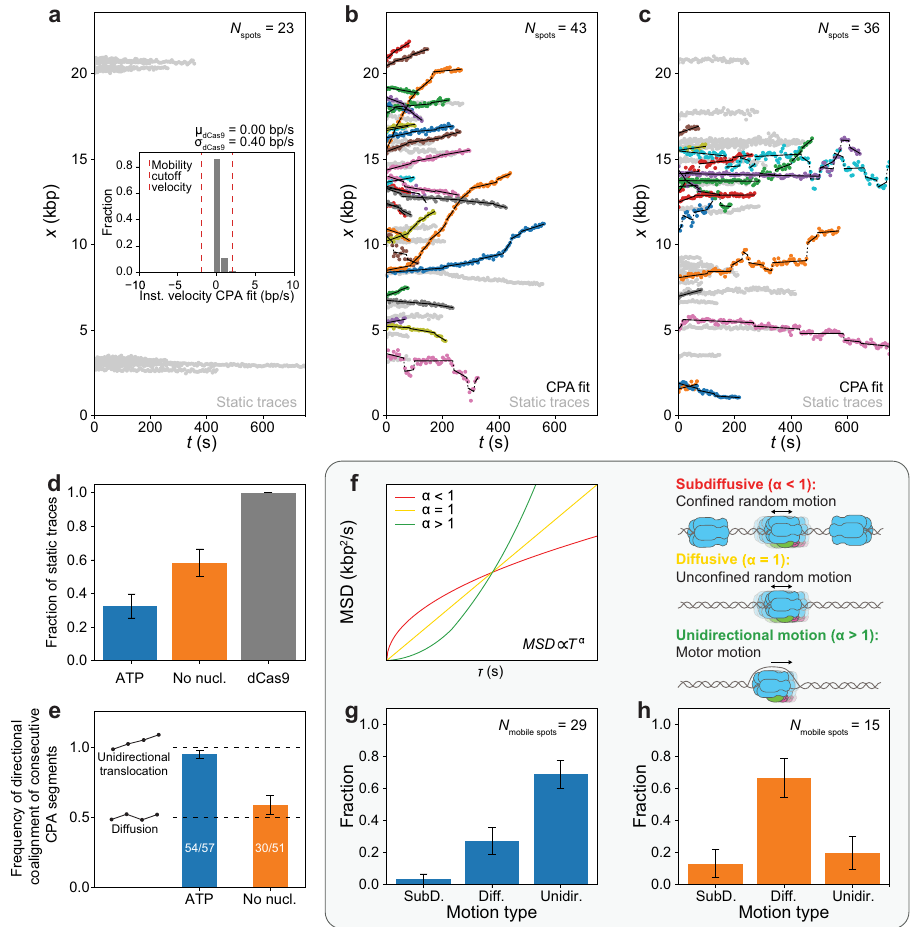
Fig. 2 | Fully reconstitutedCMGexhibitstwo different motion types. a Position vs. time plots of dCas9 LD555 spots; (inset) distribution of instantaneous velocities coming from the CPA fi ts of dCas9 LD555 spots; red lines show the instantaneous velocitycutoff(5 σ dCas9 )usedtoseparateCMGspotsin b and c intostaticormobile; CPA fi ts are not shown for clarity. b , c Position vs. time plots of CMG spots in the b presence of ATP or c absence of nucleotide; CPA fi ts are plotted in black, static traces are shown in light gray. d Ratio of static CMG traces in the presence of ATP ( N spots =43), absence of nucleotide ( N spots =36), and static dCas9 ( N spots =23) tra- ces; error bars show the standard error of proportion. e Frequency of consecutive CPA segments with the same direction for CMG spots in the presence of ATP